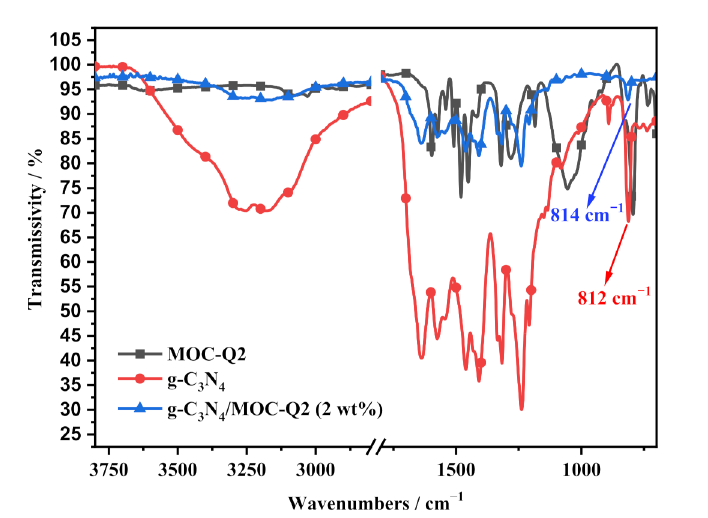
Figure 4. FT-IR spectra of g-C 3 N 4 , MOC-Q2, and g-C 3 N 4 /MOC-Q2 (2